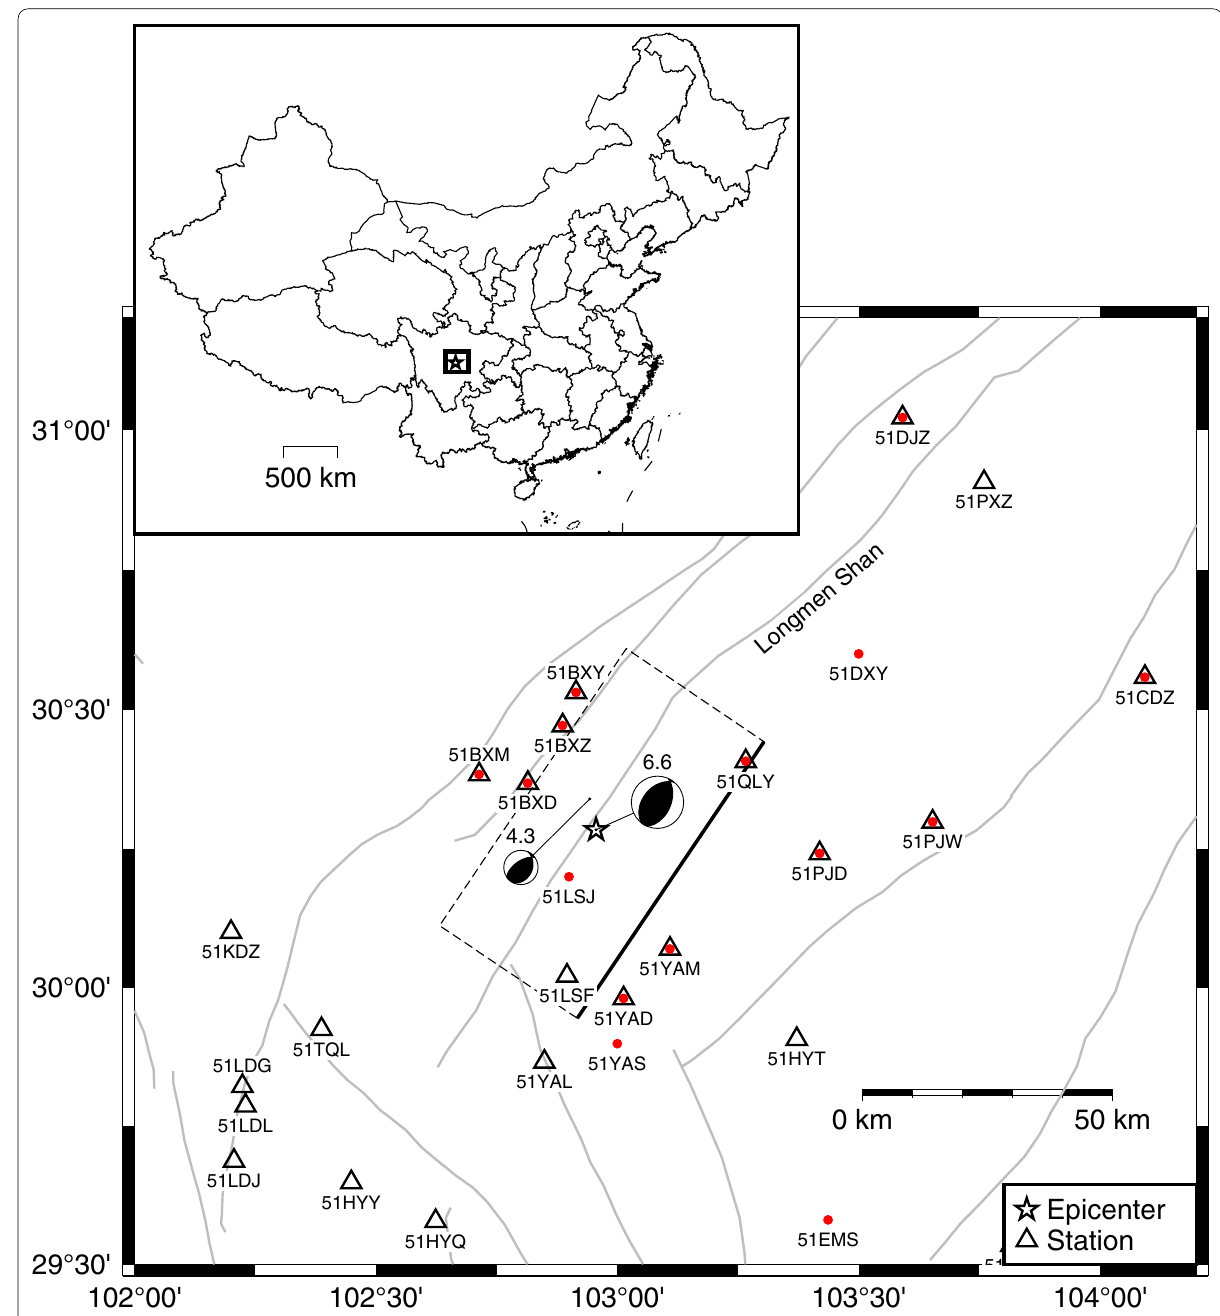
Fig. 1 Distributions of strong motion stations during the mainshock ( M w 6.6) and the EGF event ( M w 4.3). The large rectangle denotes the projection of the kinematic source model (Li et al. 2017), of which the thick line part denotes the top edge of the fault. The focal mechanisms are shown with beach balls. The star denotes the epicenter of the mainshock. Triangles and solid red circles represent the strong motion stations during the mainshock and the EGF event, respectively. Gray lines show fault traces (Deng et al. 2003) in the study